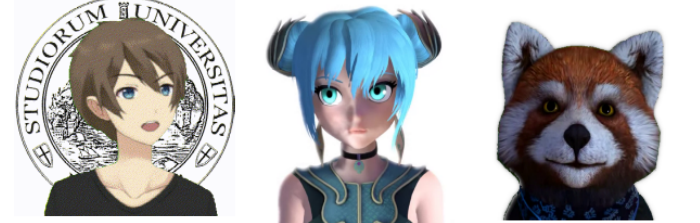
Figure 6. The three MICA tested